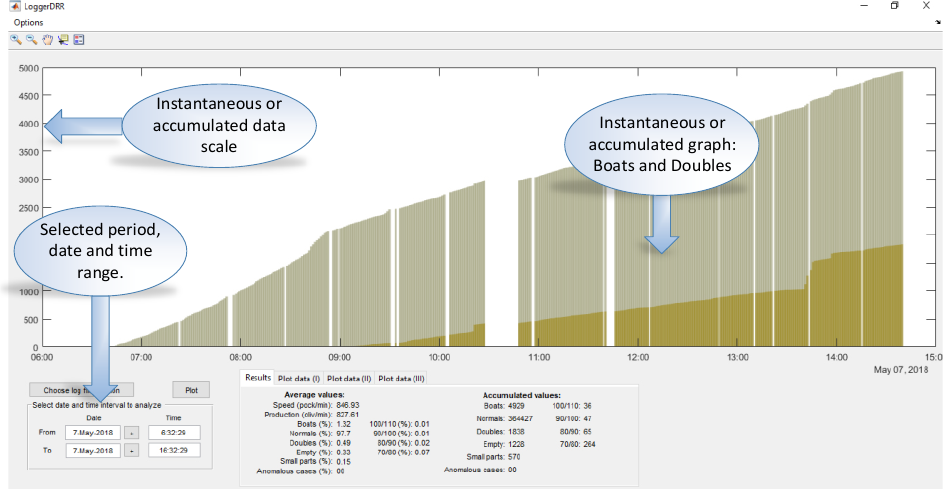
Figure 15. Graphical User Interface (GUI) created in Matlab to analyze data from the “DRR machines”. The representative data is indicated in the following box (Figure